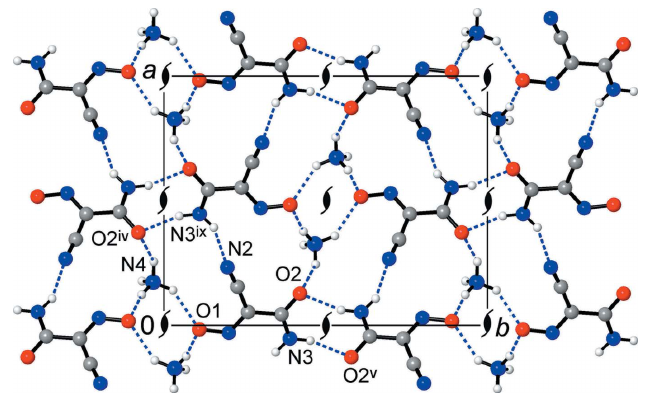
Figure 4 Structure of the title compound, viewed in a projection onto the ab plane, showing the co-existence and interplay of the three main supramolecular motifs in the form of ammonium/nitroso chains, amide/amide chains (both of which are situated across 2 1 axes and are orthogonal to the drawing plane) and amide–nitrile mutual bonding [symmetry codes: (iv) (cid:3) x + 1 , y (cid:3) 1 , z (cid:3) 1 ; (v) (cid:3) x , (cid:3) y + 1, z + 1 ; (ix) x + 1 , (cid:3) y + 1 , z ]. 2 2 2 2 2 2